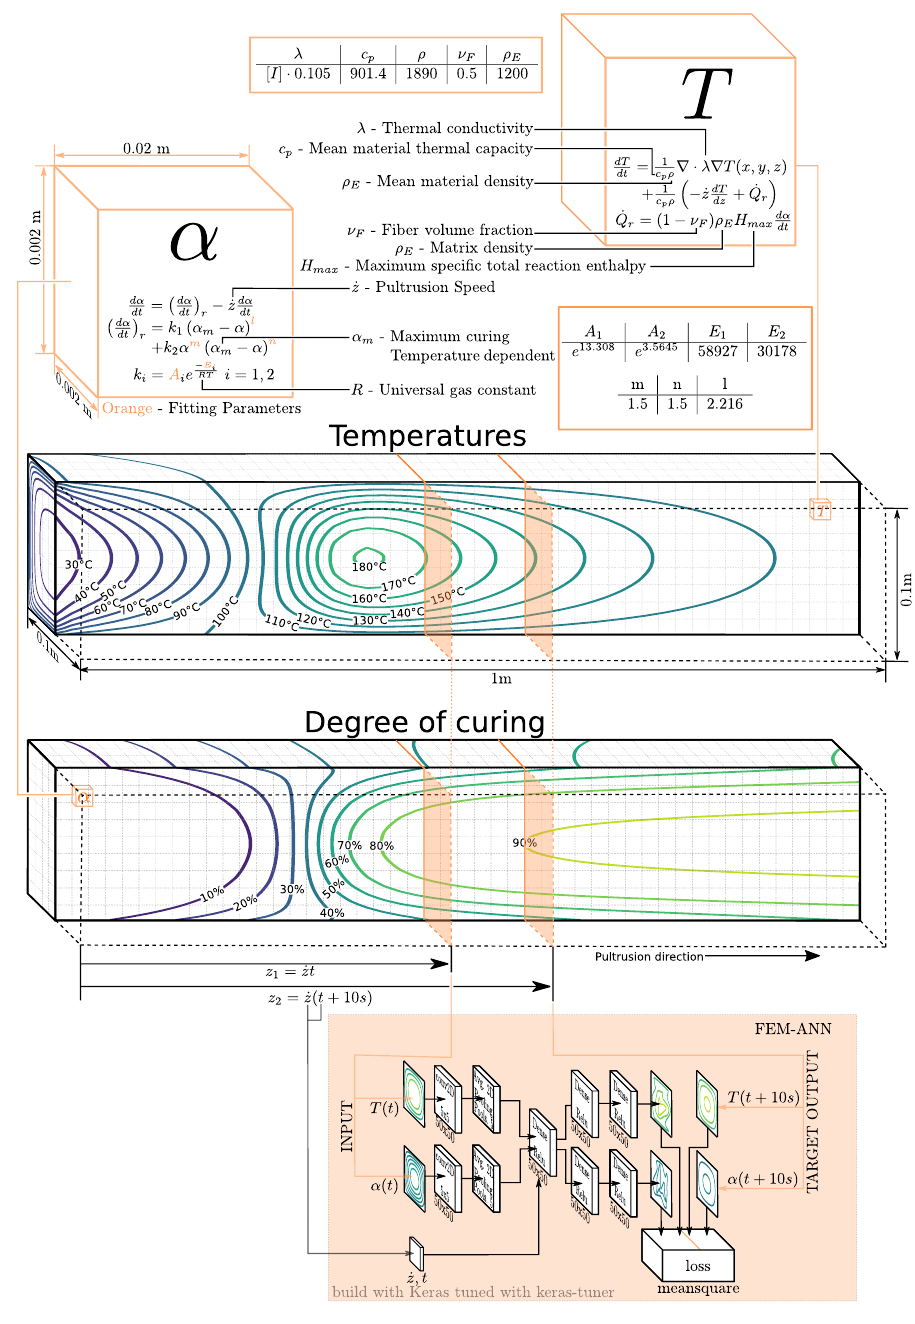
Figure 3. Setup for